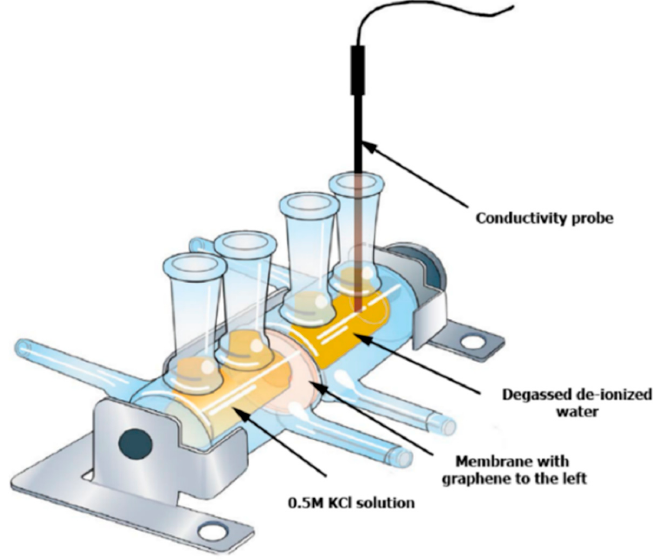
Figure 2. Side-Bi-Side diffusion cell used to study ionic transport.